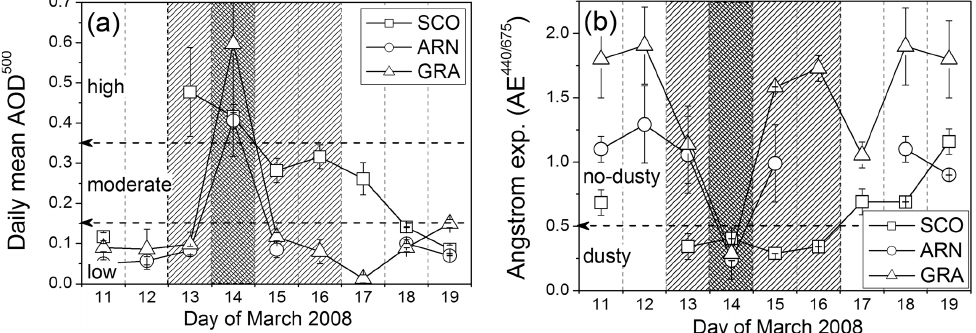
Fig. 3. (a) Daily mean AOD at 500nm (AOD 500 ) and (b) ˚Angstr¨om exponent (AE 440 / 675 ) for the three stations (see legend). Dusty periods are marked by light- and dark-shaded areas over SCO and ARN/GRA sites, respectively.